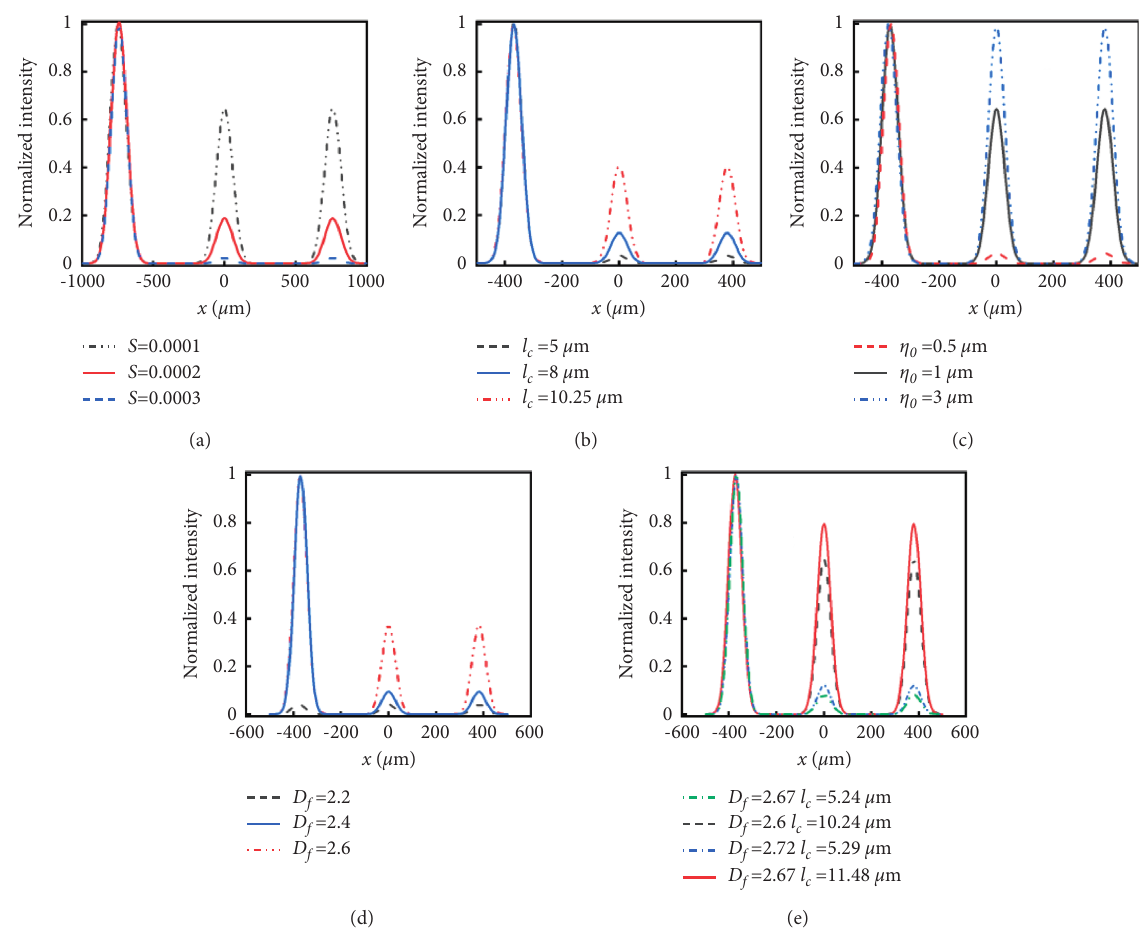
Figure 4: Normalized intensity distribution of the TGSMA beams at propagation distance z � 200um for different biological tissue parameters, (a) D f � 2.60, l c � 10.24 μ m, η 0 � 1 μ m; (b) D f � 2.60, S � 0.0001, η 0 � 1 μ m; (c) D f � 2.60, l c � 10.24 μ m, S � 0.0001;